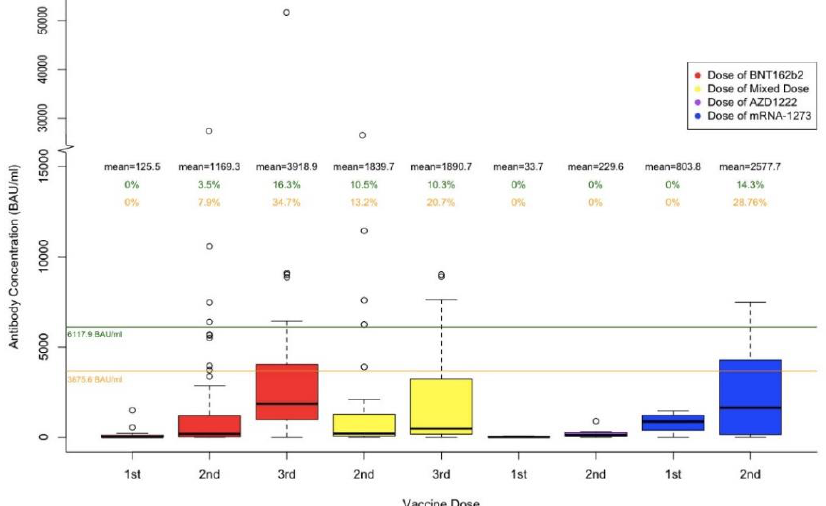
Figure 3. The upper green line of 6117.9 BAU/mL is the second highest antibody concentration prior to a known breakthrough infection (post 3rd dose, blood drawn 39 days prior to PCR confirmed infection). The lower orange line of 3675.6 BAU/mL is the average of antibody concentrations in eleven infections confirmed by PCR. The percentages shown in green represent the percentage of antibody concentration that is above 6117.9 BAU/mL per each dose of each vaccine type. The percentages shown in orange represent the percentage of antibody concentration that is above 3675.6 BAU/mL per each dose of each vaccine type.